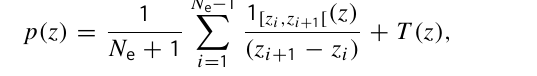
Figure 4. Same as Fig. 2 but for the